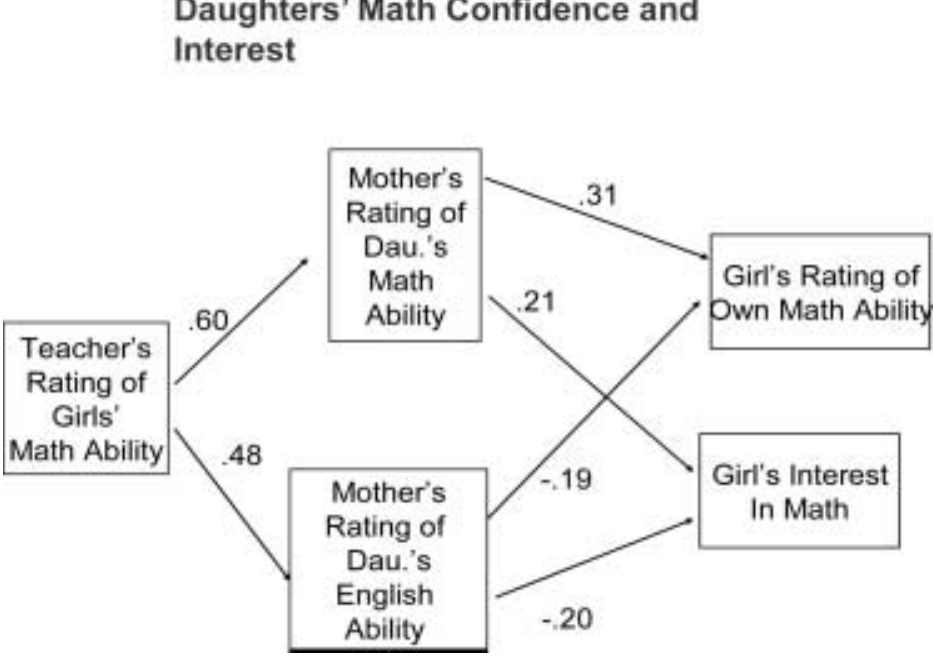
Figure 6. Impact of mothers’ beliefs on daughters’ math confidence and